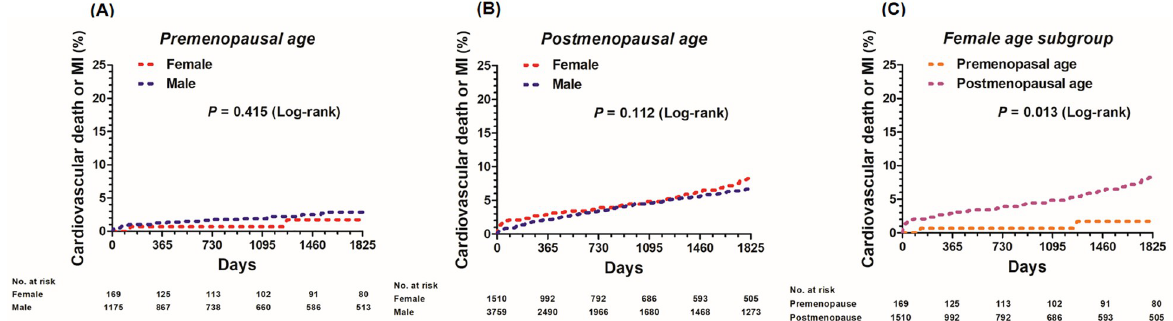
Fig 3. Kaplan-Meier curves comparing 5-year risk of cardiovascular death or MI in female patients undergoing CABG by age. CABG = coronary artery bypass grafting, MI = myocardial infarction.